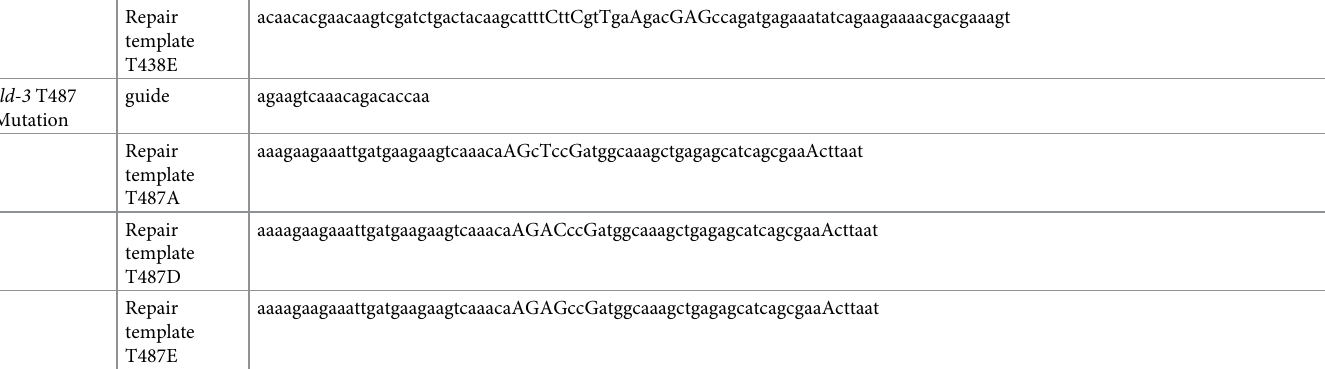
CRISPR strains were generated according to [50]. Reagents were purchased at IDT. For injec- tions the N2 wildtype strain was used. Injection mix contained the dpy-10 marker to identify jackpot broods. 10 μ l injection mix was prepared. TracrRNA (360 μ M) 0.24 μ l, dpy10 RNA mixed and incubated at 95C for 5min. Mix was put at RT for 5min to cool down. 0.25 μ l Cas9 was added and waited for another 5min before the rest was added to the final mix. 0.2 μ l dpy- 10 repair template (500ng/ μ l), 0.44 μ M of repair template and water were added to a total of 10 μ l. N2 were kept at 20C post-injection and transferred to new plates after 12hrs for egg lay- ing. P0 were again transferred to new plates after 24hrs. F1 were singled out from jackpot brood consisting of about 30–40% dpys or rollers. After egg laying F1 was tested for mutation by single-worm lysis followed by PCR. For the identification of zap13 , zap15 and zap16 oligo- nucleotides in the Table above were used. The identification of the zap13 allele additionally required SmlI digest of the PCR product. Independent homozygous lines were isolated and outcrossed twice with N2 before the mutant allele was once again confirmed by Sanger sequencing.